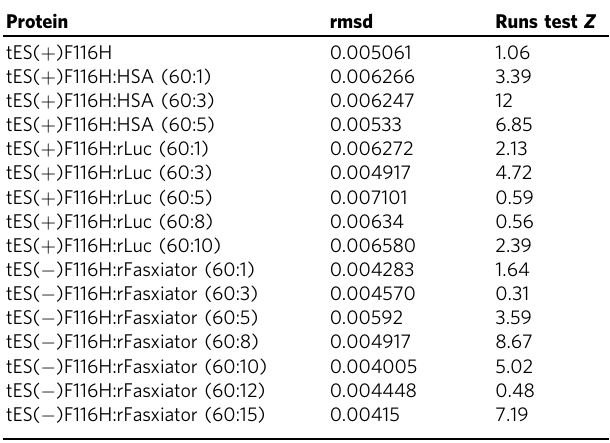
Table 2 rmsd and runs test Z values of AUC